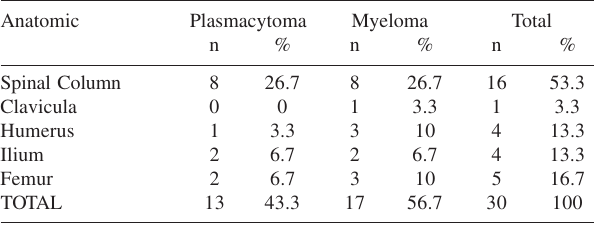
Table 8 - Anatomic location of primary tumors in patients with plasmacytoma and in patients with plasmacytoma that progressed to myeloma (absolute and relative (%) frequency